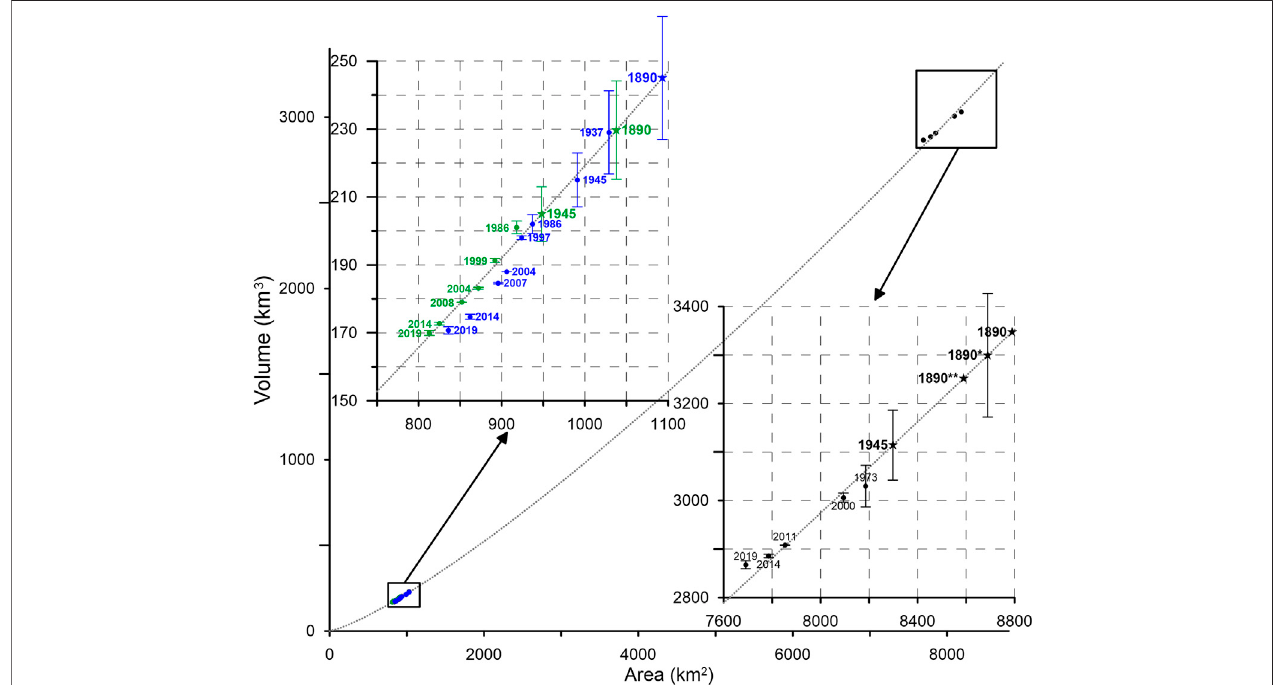
FIGURE 4 | Volume – area scatter plot for the three largest ice caps in Iceland at various times since 1890. The blue markers are for Langjökull, green markers for Hofsjökull, and the black for Vatnajökull. The dotted gray line shows the least square fi t of Eq. 1 through all volume – area points for these ice caps. Inset fi gures show a zoom inof theplot for theclusterswithdata from Hofsjökull and Langjökull (upper left corner) and Vatnajökull (lower right corner) . Labels by the fi lled circles indicate dates when both area (Hannesdóttir et al., 2020) and volume are well established, while labels beside stars indicate dates of well-known area, with volume estimated from the deduced volume – area relation (dotted gray line). The 1890 values are obtained using area based on geomorphological evidence of the Little Ice Age maximum extent (Hannesdóttiret al., 2020).The1890* and 1890** forVatnajökullshowthe volume estimates withthe reduced areatocompensate forthe large portion of surging outlets from Vatnajökull (see main